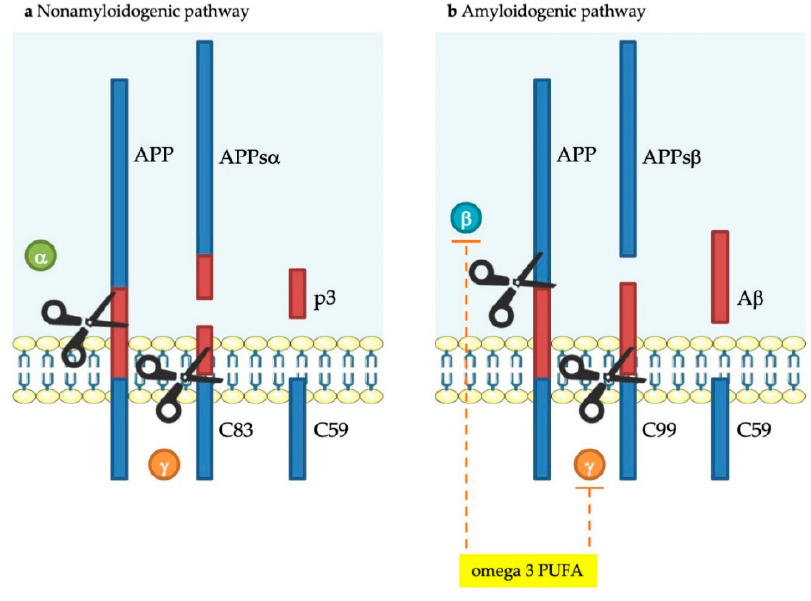
Figure 2. Amyloid precursor protein (APP) processing pathways. The non-amyloidogenic pathway ( a ) occurs upon sequential cleavage by α - and γ -secretases (non-pathological situation). The amyloidogenic pathway route ( b ) occurs when cleavage is carried out sequentially by β - and γ secretases (pathological situation). Letters α , β , and γ represent each type of secretase. APP: Amyloid precursor protein, APPs α : Soluble α -APP, APPs β : Soluble β -APP. Omega-3 polyunsaturated fatty acids, proposed to inhibit APP processing, are shown in orange dashed lines.